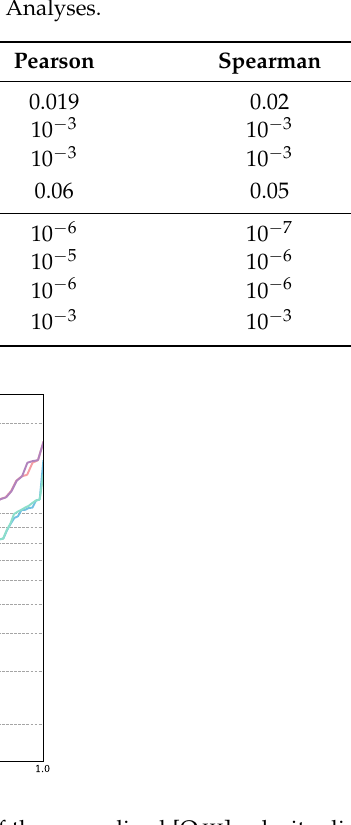
Figure 12. The cumulative fractions of the normalized [O III ] velocity dispersion of our classified subsamples. Colors are identical to Figures 7 and